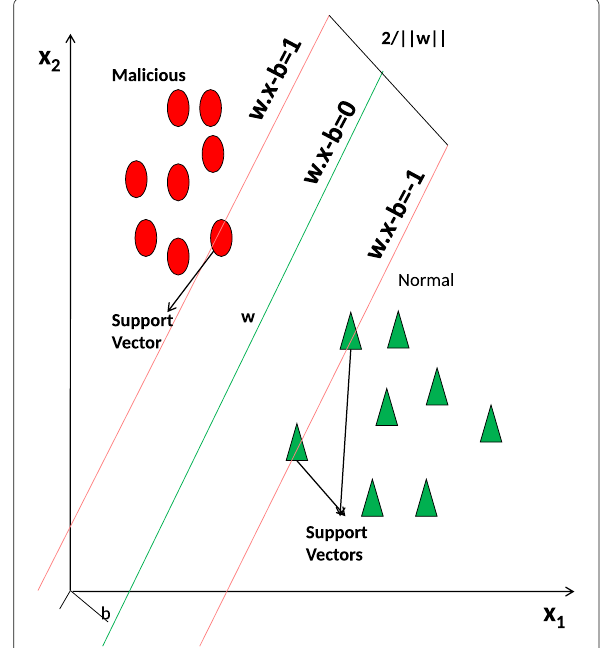
Fig. 2 The value of w affects the position of the hyperplane